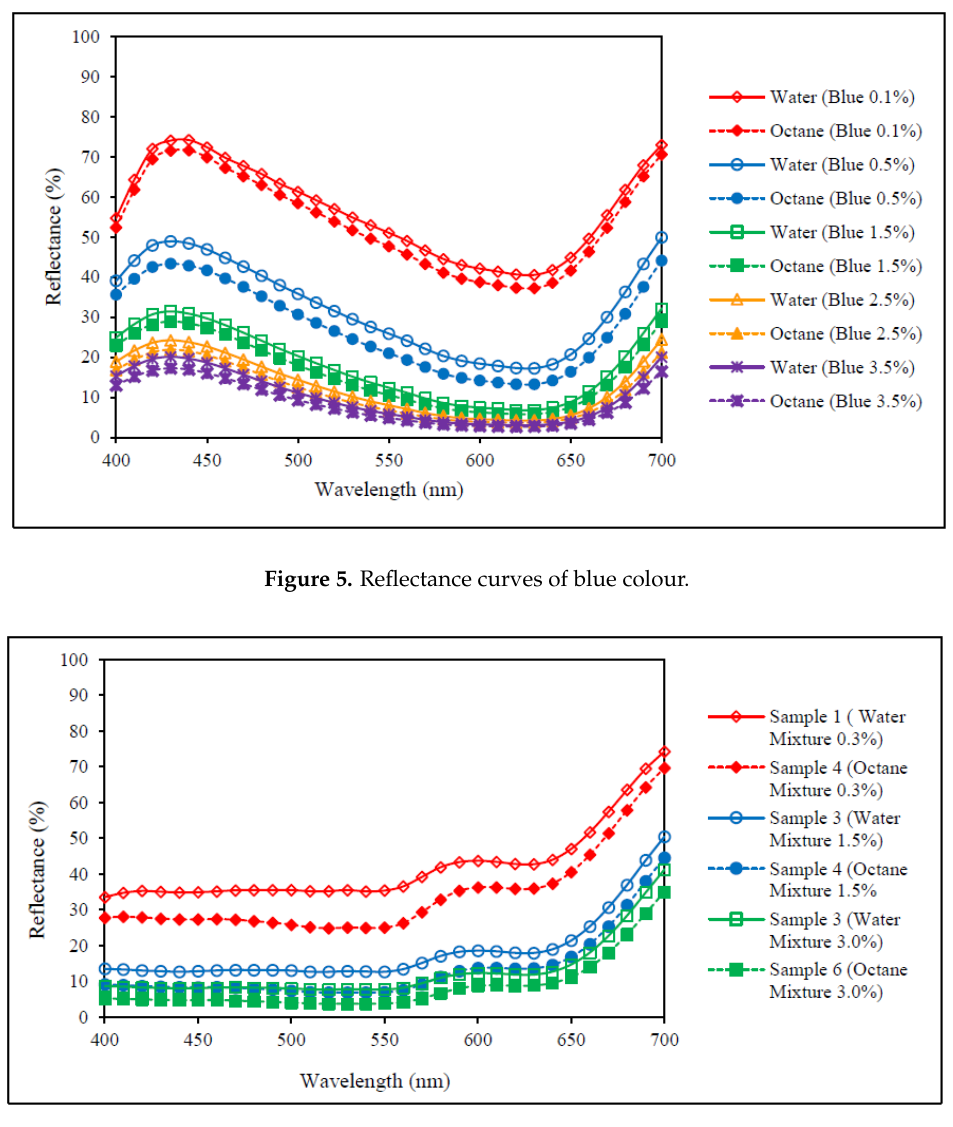
Figure 6. Reflectance curves of colour mixture.